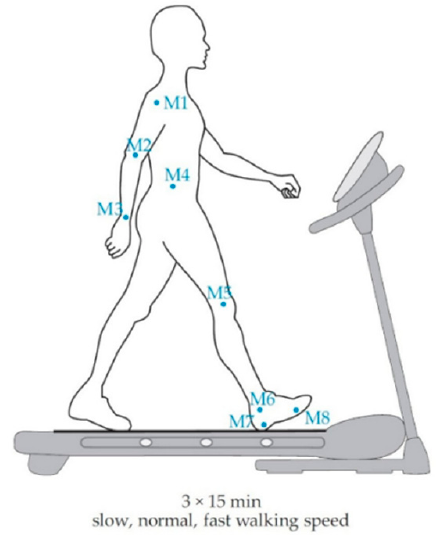
Figure 1. Derivation of the model [57].